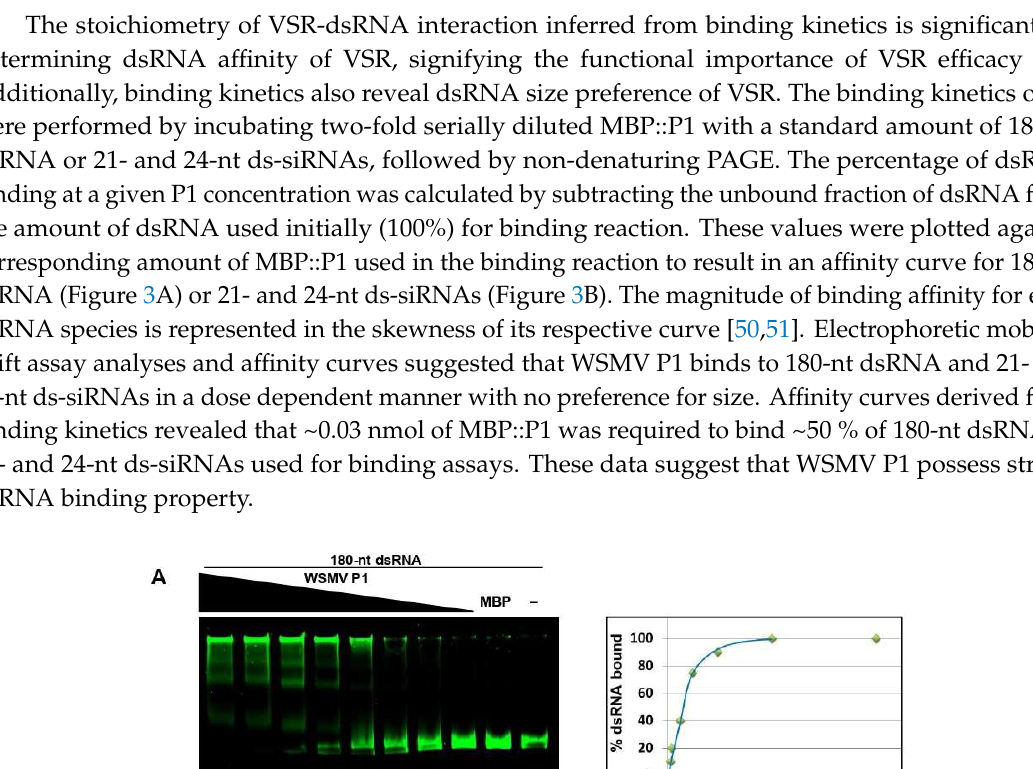
8 of 18 Figure 2. WSMV P1 interacts with dsRNA with no size specificity. ( A ) SDS-PAGE showing the affinity purified MBP::P1 (lane 2), MBP::P1-W303A (lane 3) and MBP (lane 4) expressed in E. coli and stained